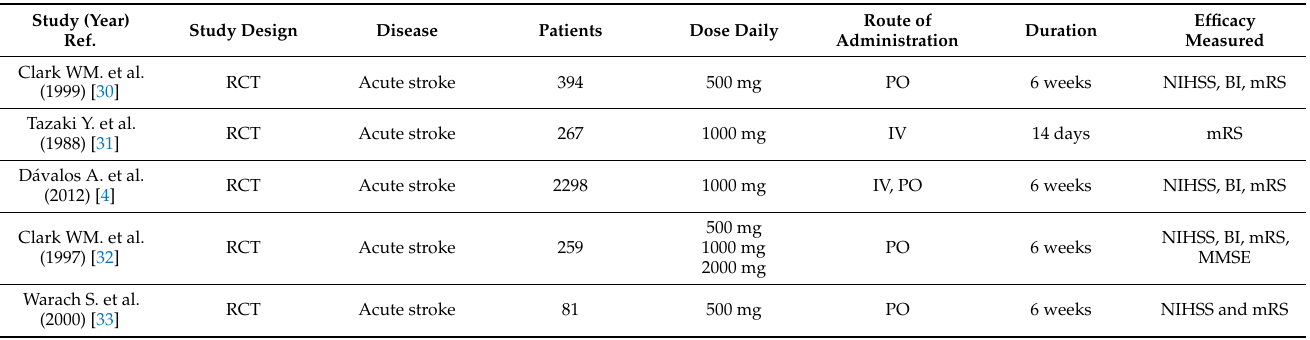
Figure 1. Flowchart illustrating the process of study search, selection, and inclusion in this systematic review and meta-analysis using PRISMA 2020 [29]. Table 1. Characteristics of included studies.